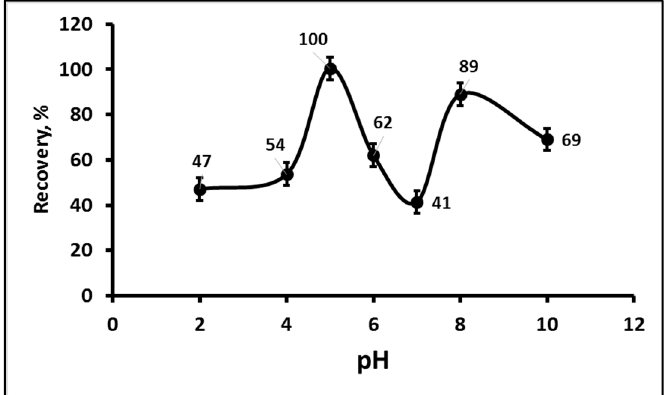
Figure 1. The effect of the apparent pH on the recovery of carbaryl from A100 Al-based MOFs ( n = 3).